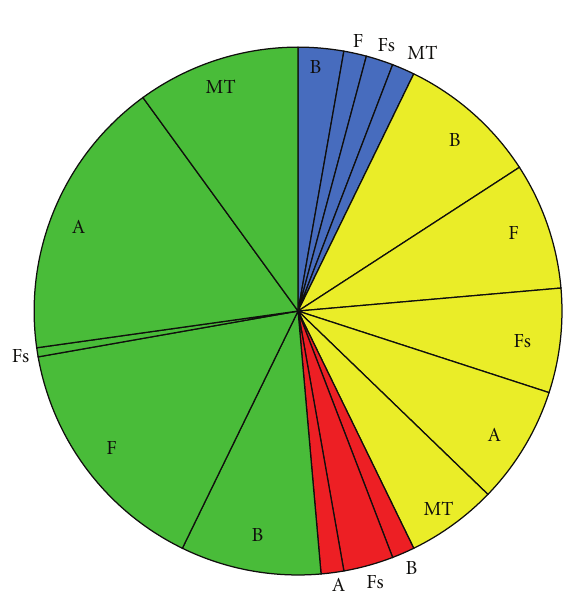
Figure 4: Pie chart representing the proportion of impacts for each ecosystem component for Impact scenario i3, wind turbine project involving no pile driving, categorized by whether the e ff ect is positive (blue), minor negative (green), moderate negative (yellow), or major negative (red). B = Benthic habitat and resources; F = Fish; Fs = Fisheries; A = Avian species; MT = Marine mammals and sea turtles.